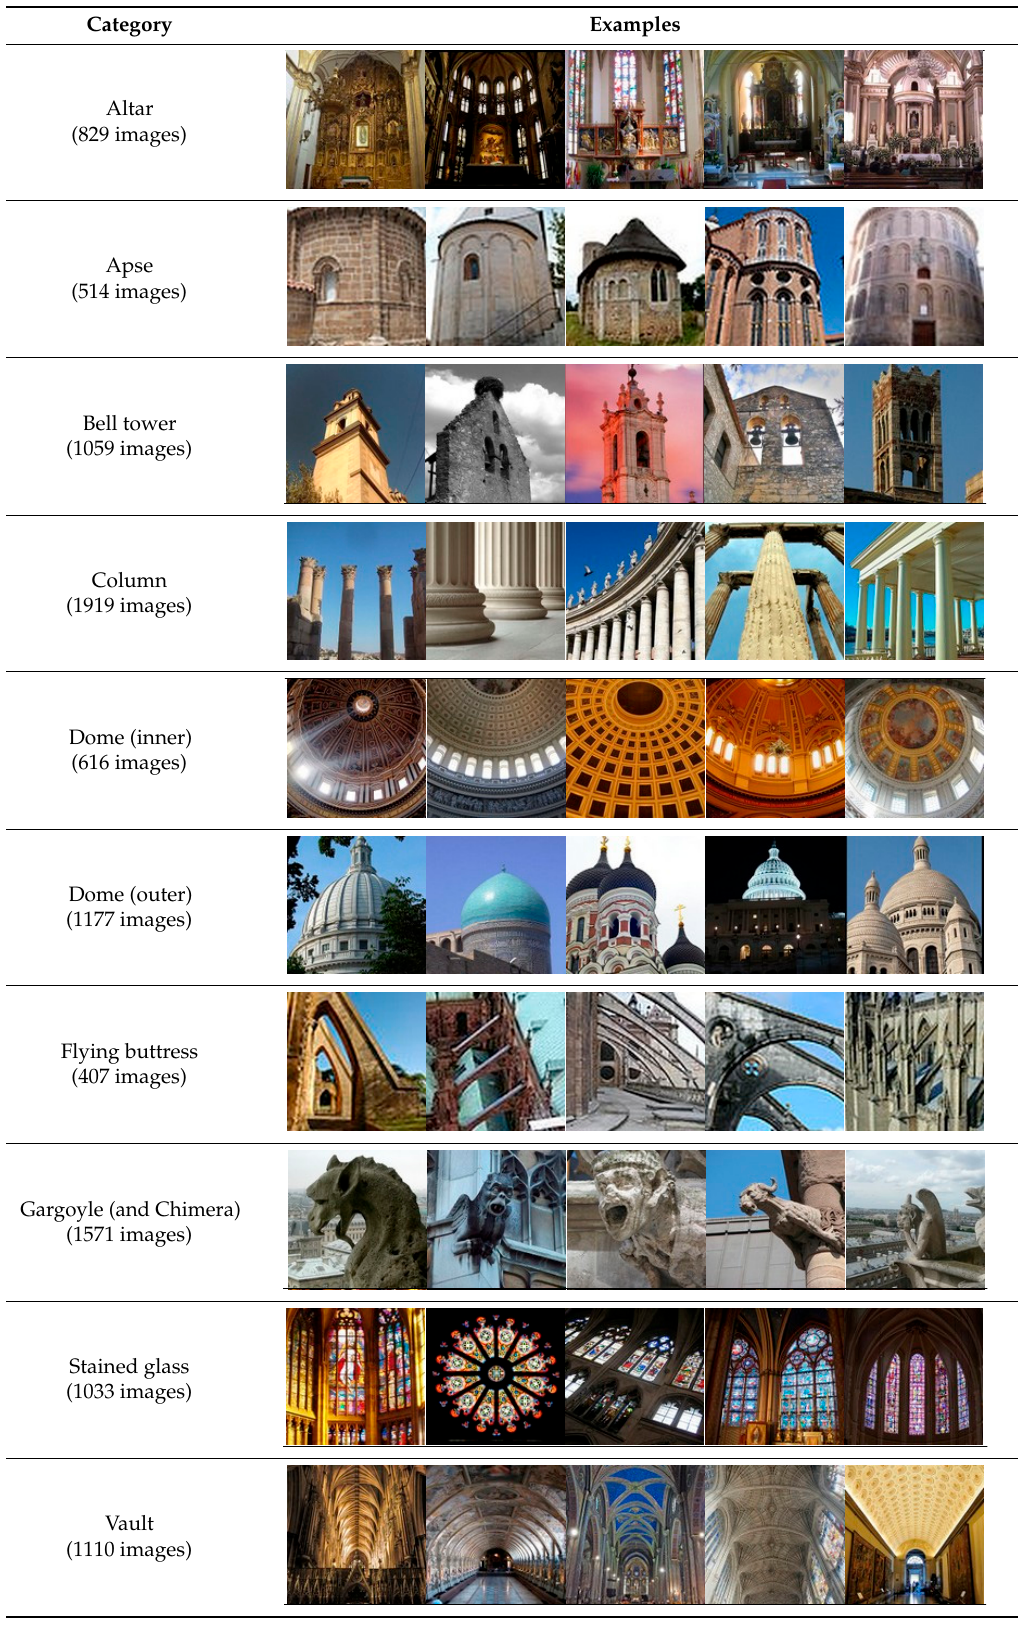
Table 1. Dataset samples of Cultural Heritage images used.